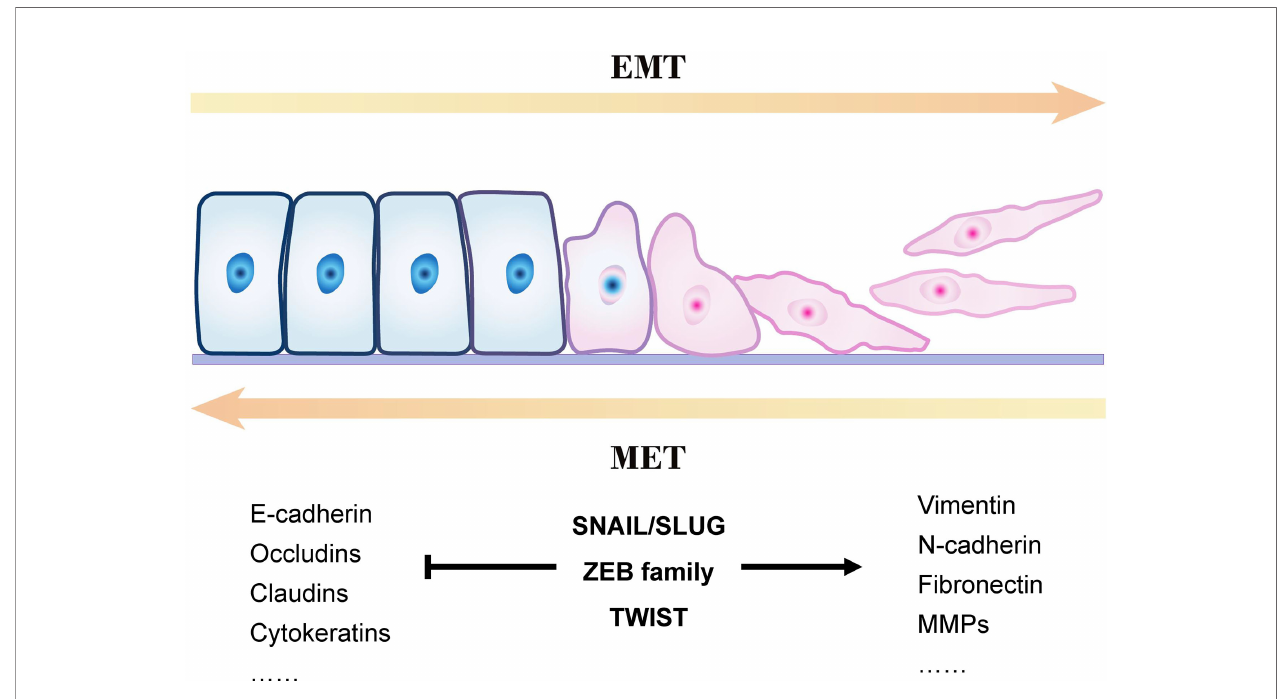
FIGURE 1 | Outline of a typical epithelial – mesenchymal transition (EMT)